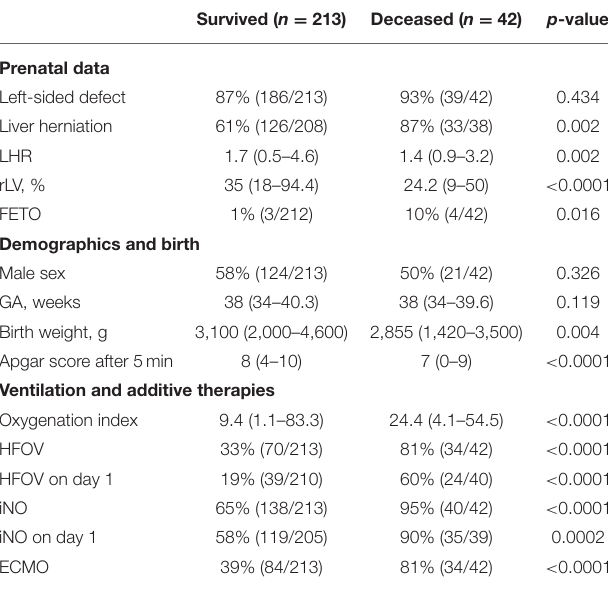
TABLE 2 | Comparison of patient characteristics in relation to survival. TABLE 3 | Comparison of patient characteristics in relation to ECMO